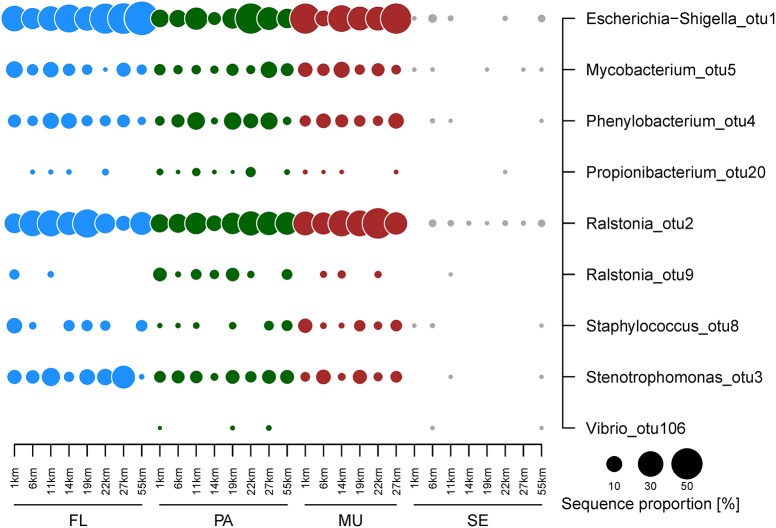
Relative abundance of potentially pathogenic bacterial OTUs identified in the free-living (green circles), particle-attached (blue circles) fraction of the water column, as well as Fungia mucus (red circles) and sediments (gray circles). OTU numbers indicate decreasing ranked total abundance in the data set.